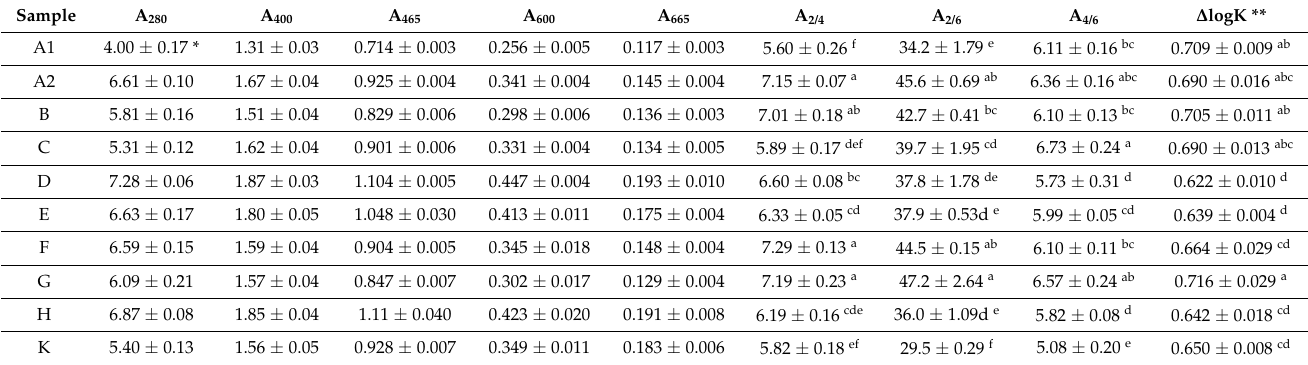
Table 7. Absorbance values and coefficients of absorbance of humic acids.